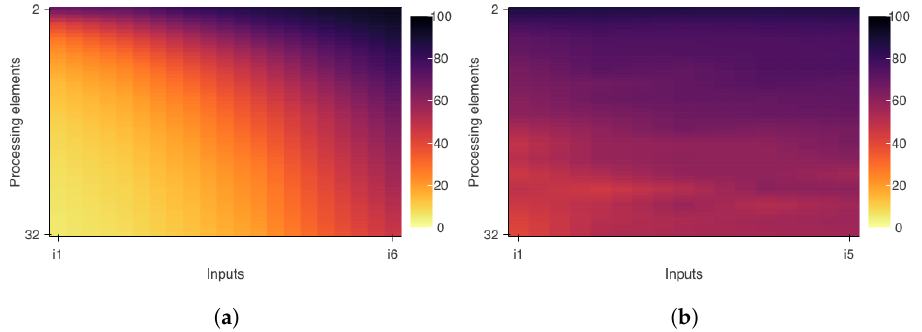
Figure 8. Efficiency diagram varying the input size and the number of cores. The color bar indicates the efficiency value in percentage. ( a ) Raytrace efficiency diagram. ( b ) OpenMC efficiency diagram. The input values shown in Figures 6–8 indicate different data sets for